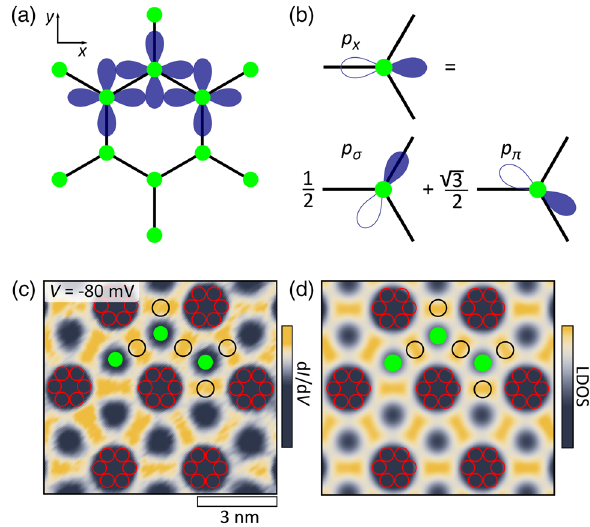
4. (a) Schematic of p orbitals (blue) in a honeycomb arrangement of artificial-atom sites (green). (b) Decomposition of a p x orbital into a σ and π bond. The rotation cos ð 60 ° Þ ¼ 1 = 2 and ffiffiffi p 3 = 2 give the prefactors for these rotations, cos ð − 30 ° Þ ¼ respectively. (c) Differential-conductance map acquired at V ¼ − 80 mV above a honeycomb lattice, shown for a part of the lattice. Several artificial-atom sites (green), the σ -bond overlap of the p -like orbitals (black contours), and CO molecules (red contours) are indicated. The map was acquired at − 6 pm ¼ 1 nA, V ¼ 150 mV, with a with respect to the set point I set set ¼ 10 mV. (d) The corresponding LDOS bias modulation V rms map simulated using the muffin-tin